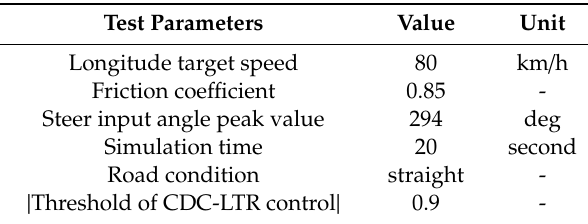
Table 3. Main parameters of fishhook test.